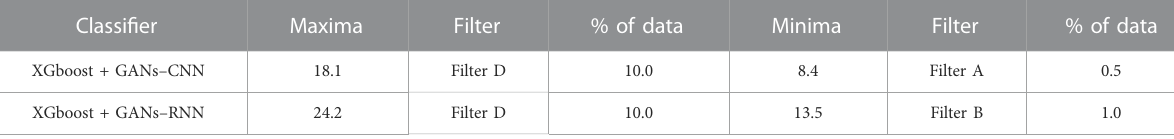
TABLE 6 Enrichment Ratios of ADRB2 on the dataset consisting of features as shown in Table 5 with training size of